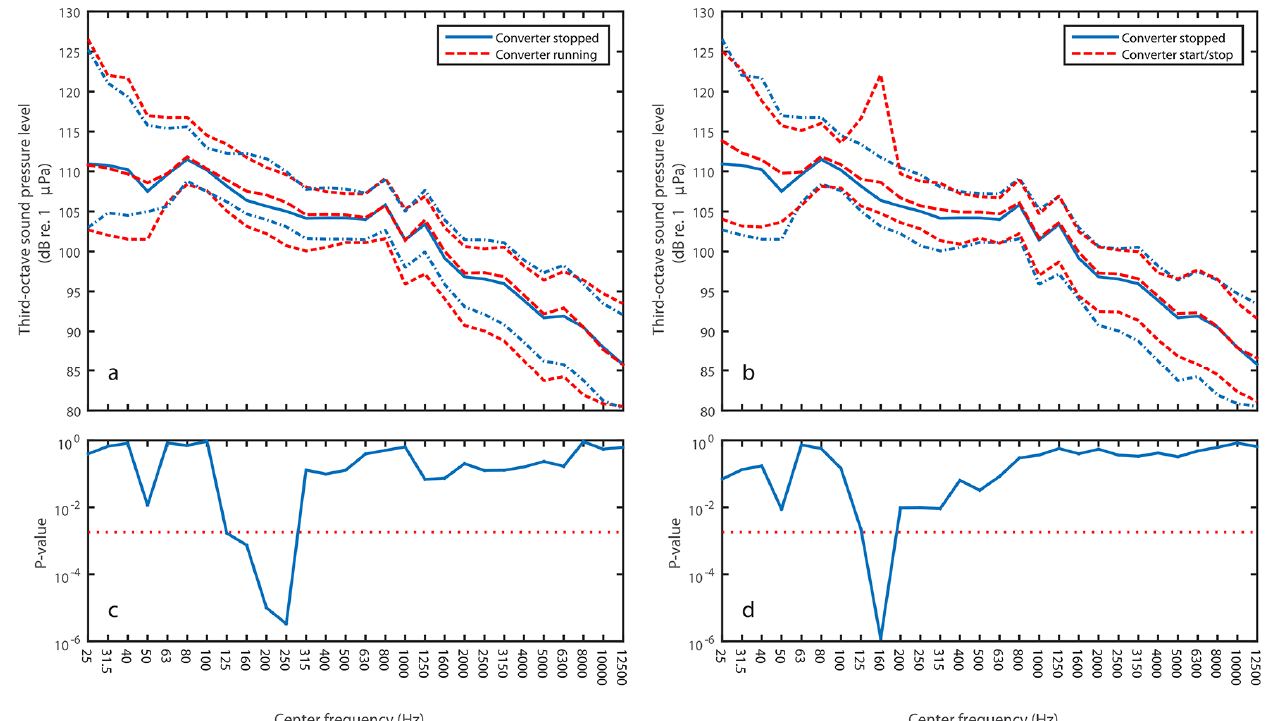
Figure 22. Noise pollution in the ocean generated by tidal ( a , c ) and wave energy converters ( b , d ) (adopted from [205] under CC BY-SA 4.0 license).